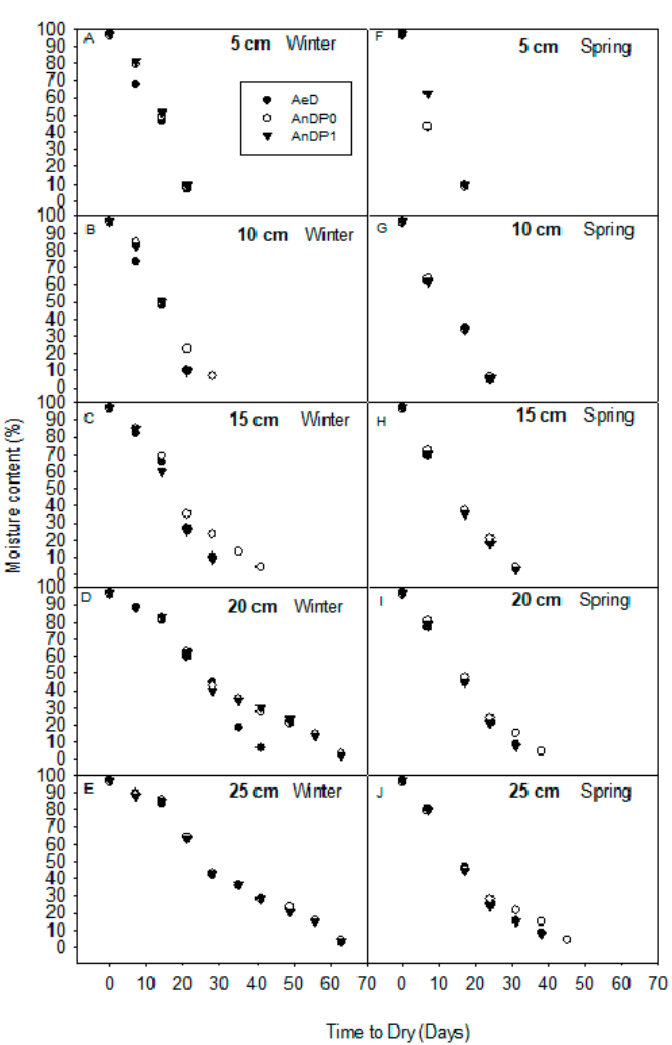
Figure 2. Moisture content change over time during sludge drying at 5 to 25 cm drying depth in winter ( A – E ) and spring ( F – J ).